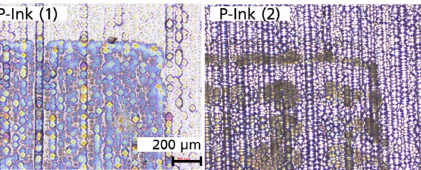
Figure 14. Optical microscope images captured at a resolution of 200 µ m, after high-temperature annealing in a tube furnace, for P-ink (1) and P-ink (2), printed on a saw-damage-etched surface of the CZ-Si wafer at a resolution of 600 × 600 dpi [16].